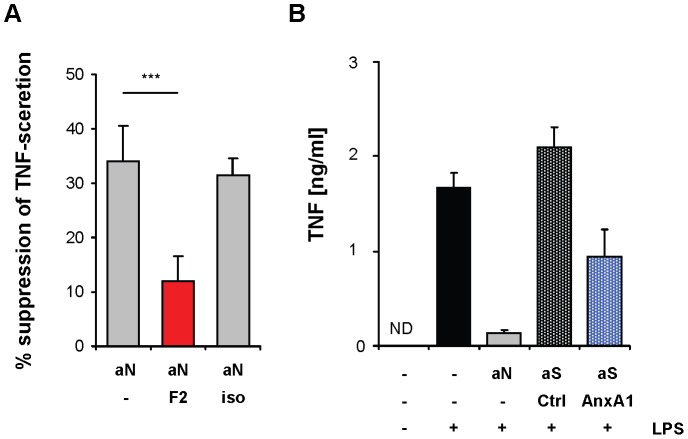
Apoptotic cells suppress DC activation via externalization of annexin A1.(A) Immature DC were incubated with apoptotic neutrophils (aN) together with anti-annexin A1 F(ab’)2-fragments (F2, 50 µg/ml) or isotype control F(ab’)2-fragments (iso, 50 µg/ml). After stimulation with CpG (0.05 µM) for 12 h, the concentration of TNF in culture supernatants was determined by ELISA. Depicted is the suppression of TNF secretion by apoptotic neutrophils in comparison to DC stimulated alone. Error bars represent means +/− SD of 3 independent experiments. ***P<0.001. (B) Immature DC were cocultured with apoptotic neutrophils (aN) or with apoptotic Drosophila Schneider cells (aS), transfected with annexin A1 (AnxA1) or a control plasmid (Ctrl). Subsequently, cultures were stimulated with LPS (1 ng/ml), and concentrations of TNF in culture supernatants were determined by ELISA. Error bars represent means +/− SD of duplicate cultures. Data are representative of 3 independent experiments.